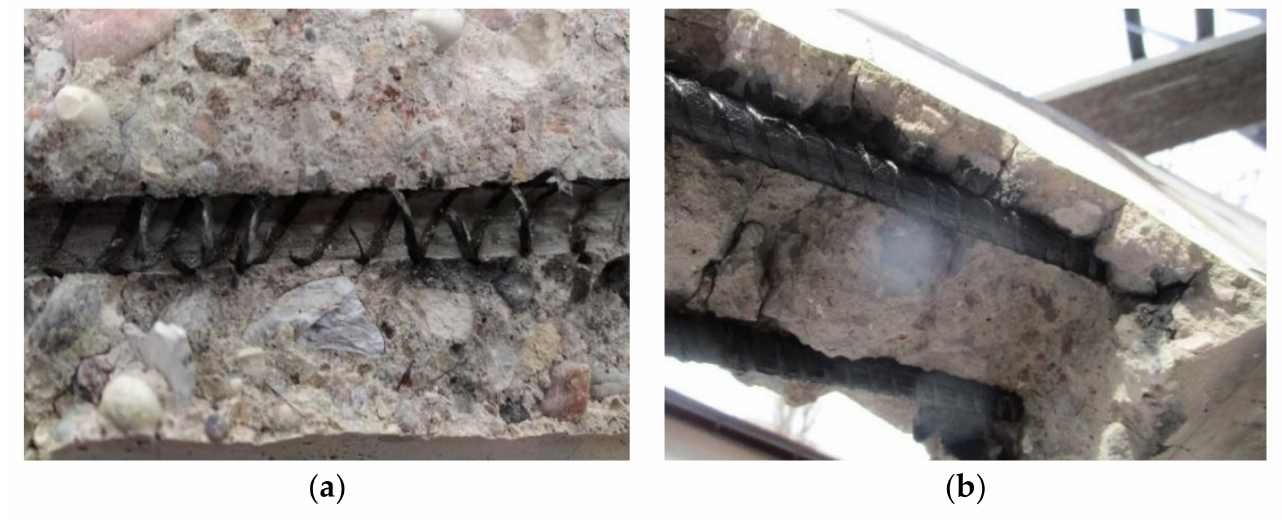
Figure 7. Removal of bars from concrete beams: ( a ) middle part of the beam; ( b ) side part of the